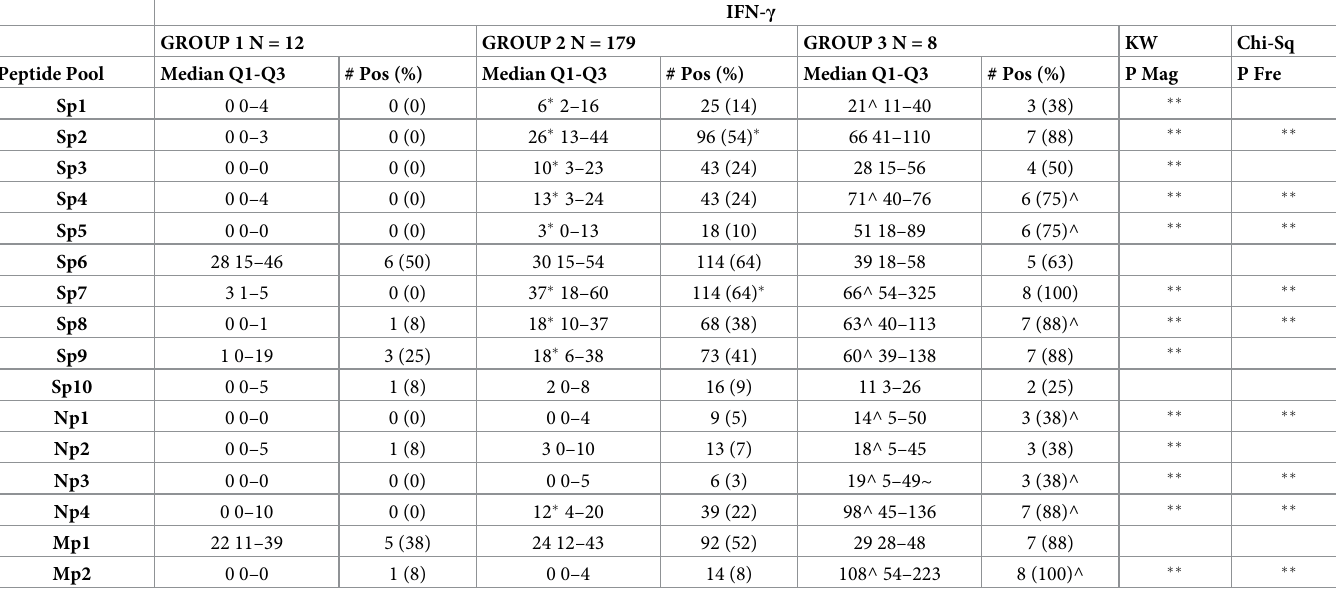
Table 2. FluoroSpot IFN- γ responses to individual S, N, and M peptide